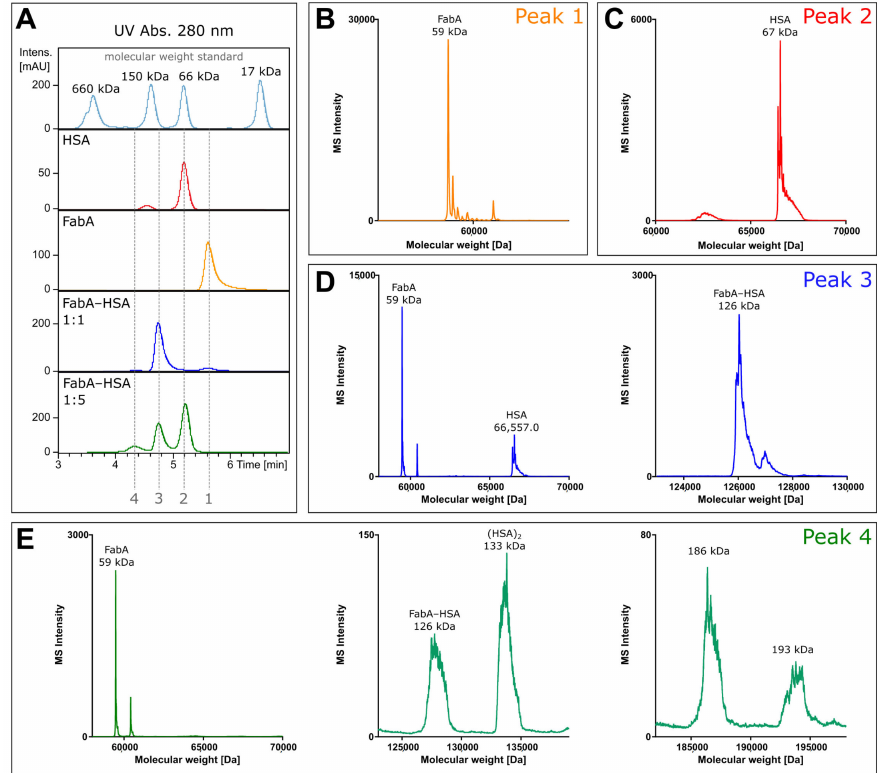
Figure 1. Native mass spectrometry of intact proteins. ( A ) UV size exclusion chromatograms FabA, HSA and FabA–HSA complexes formed after 4 h incubation with human VH supplemented with albumin (at 1:1 and 1:5 ratio). ( B ) Deconvoluted intact mass spectrum of chromatographic peak 1 corresponding to a molecular weight of FabA and ( C ) HSA. ( D ) Deconvoluted spectra of two mass ranges. The lower mass range contains FabA and HSA, while the higher mass range covers the equimolar FabA–HSA complex of 126 kDa. ( E ) Deconvoluted intact mass spectra of three mass ranges, with FabA in the lowest, FabA–HSA and dimeric (HSA) 2 in the middle, and two high molecular mass complexes of 186 and 193 kDa in the